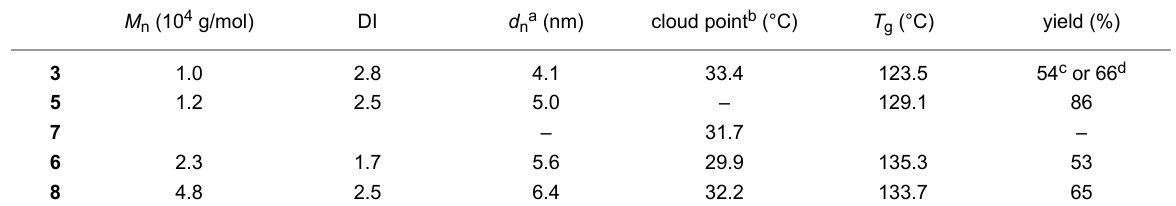
Table 1: Properties of synthesized macromonomers and polymers.